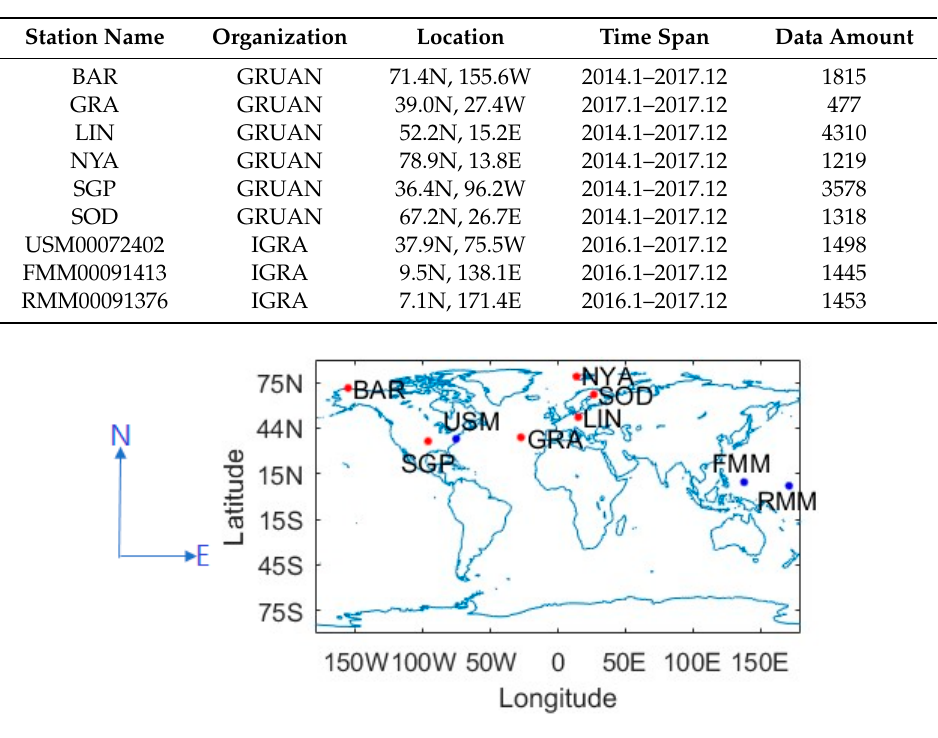
Figure 2. Radiosonde stations distribution, red dots representing GRUAN stations and blue dots representing IGRA stations.